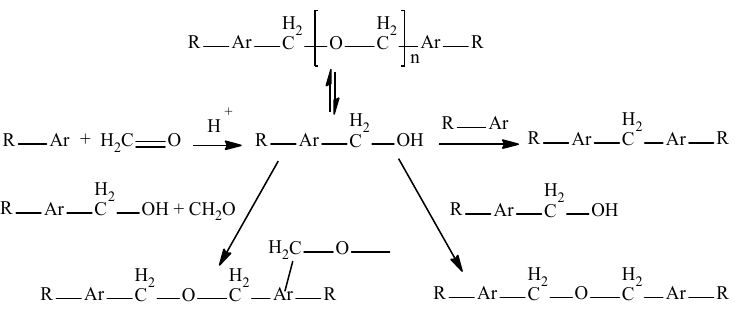
Figure 3. Chemistry of aromatic compounds copolycondensation with formaldehyde.